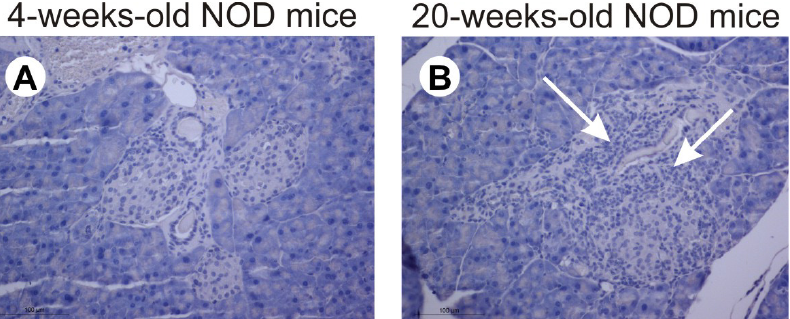
Figure 3. Insulitis is present in mature NOD mice (20-weeks-old). Representative images of pancreatic islets in prediabetic ( A ) and diabetic ( B ) NOD mice (arrows indicate the presence of immune cell infiltrates). Number of mice per group was 6. Number of inspected islets per section was 5.